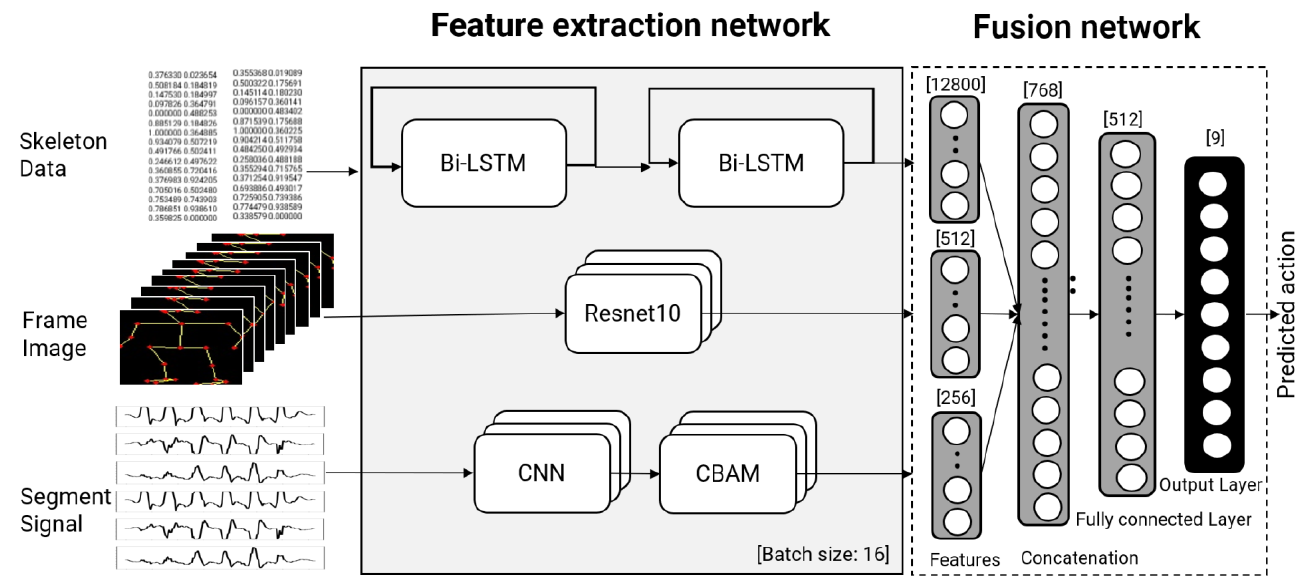
Figure 5. Deep learning model of three input cases.